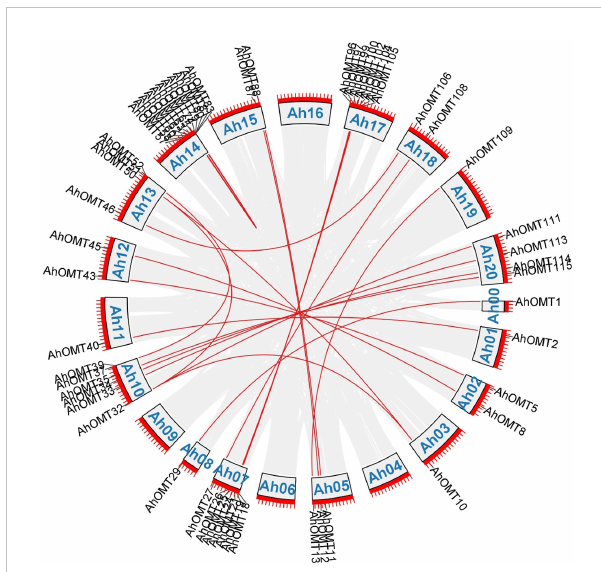
FIGURE 3 Duplicated gene pairs among AhOMTs . Out of 116 genes, 42 are duplicated genes. Red lines show the duplicated AhOMT pairs, while the gray lines in the background show the syntenic blocks (duplicated pairs) among different